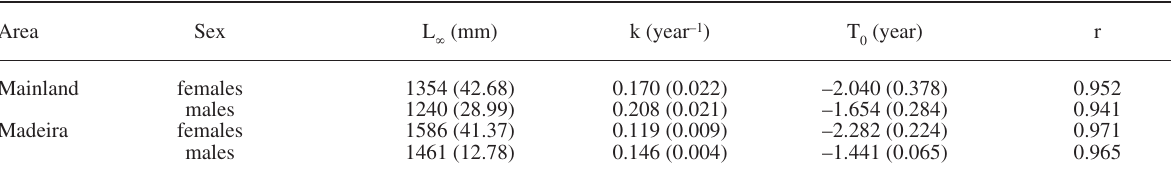
Table 7. – summary of von Bertalanffy growth model for Aphanopus carbo caught off mainland Portugal and Madeira. standard deviation in